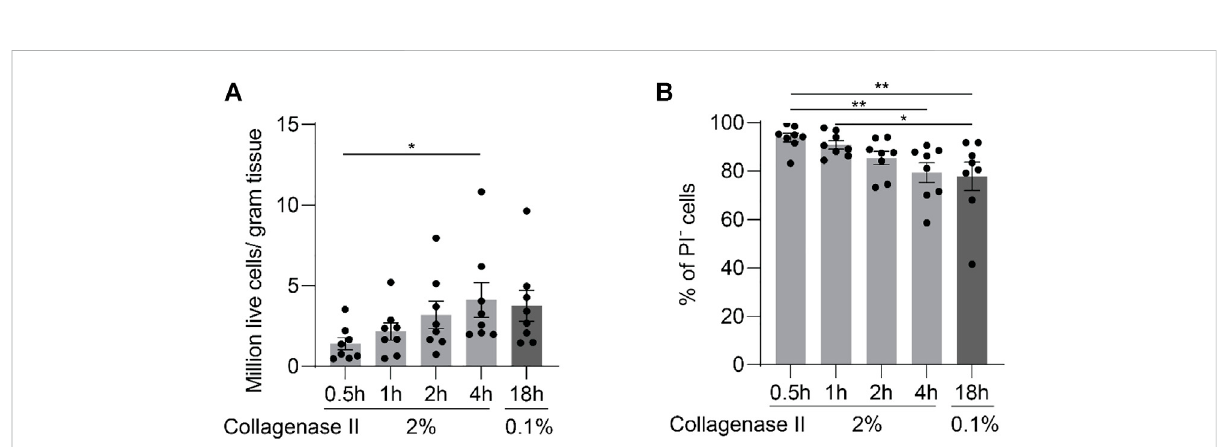
FIGURE 2 Enzymatic digestion of cartilage yields increasing cell numbers with extended digestion time for up to 4 h. After being fi nely minced, human articular cartilage tissue was divided equally into fi ve portions, and the samples were digested with 2% collagenase II for 0.5, 1, 2, or 4 h; or with 0.1% collagenaseIIfor18 h.Cellyields (A) andviabilityasquanti fi edbyFACS (B) attheendofeachdigestionprotocolareplotted(n=8patients).Datawere analyzed using paired One-way ANOVA (* p < 0.05, ** p <